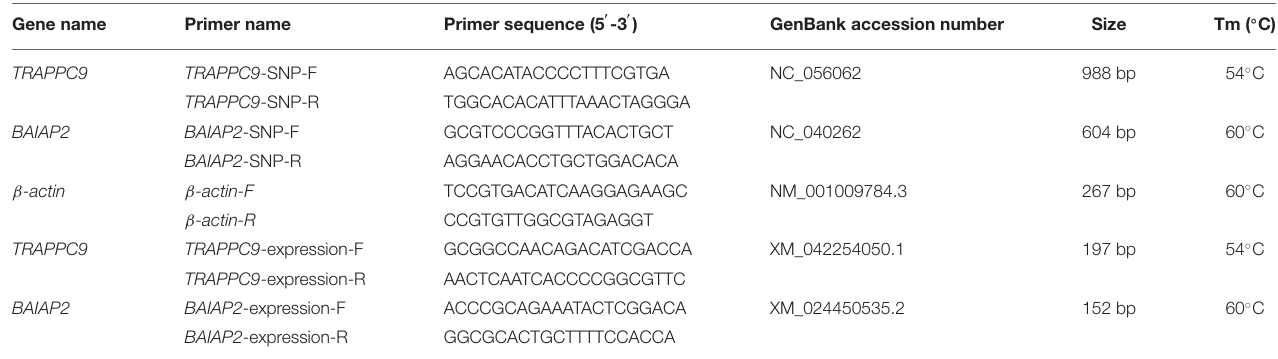
TABLE 1 | Primer pairs for the TRAPPC9 and BAIAP2 genes used for qRT-PCR and PCR amplification.